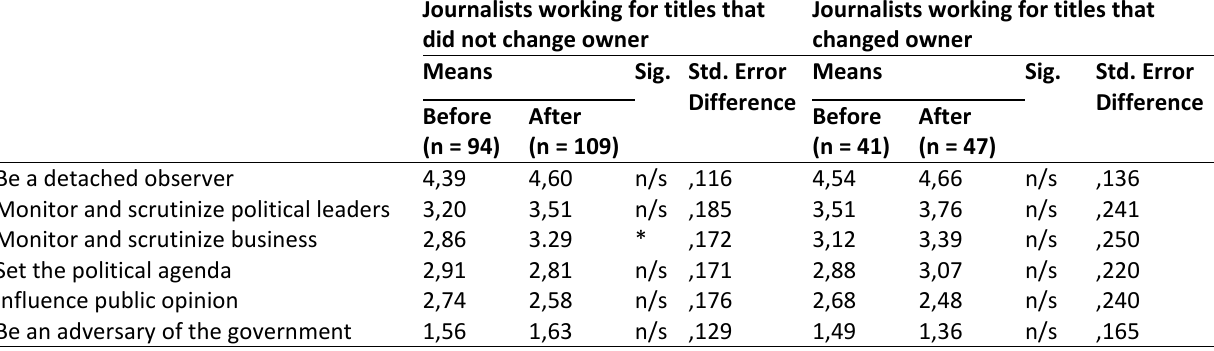
Table 3. Perception of journalistic role before and after the media takeover in 2013 (means, independent samples